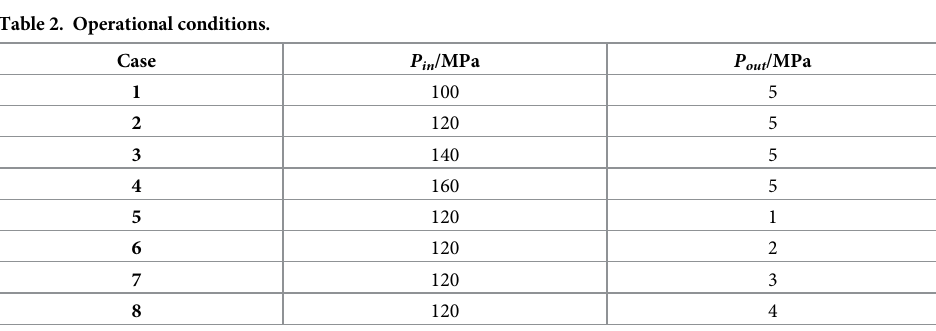
Table 2. Operational conditions.